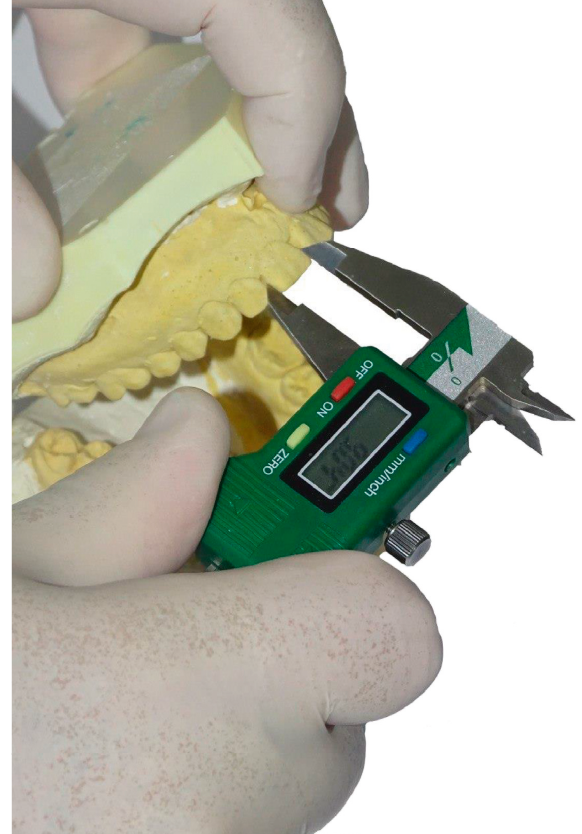
Figure 1: Measuring